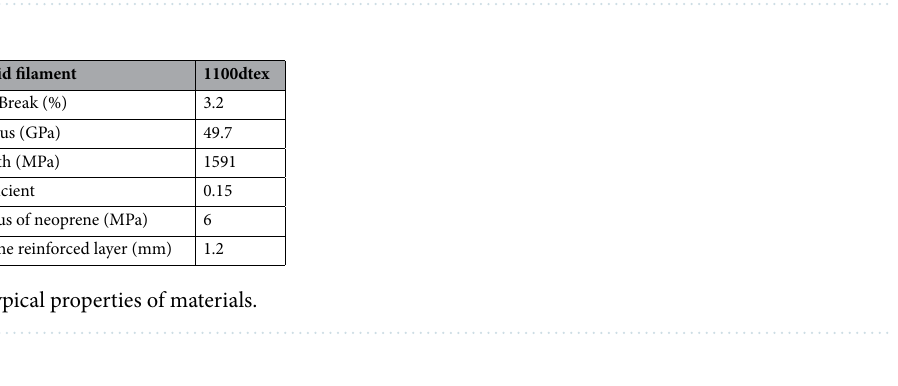
Figure 4. The geometry and boundary condition of calculated hyperbolic flexible pipe. The unit of length in the figure is millimeter.